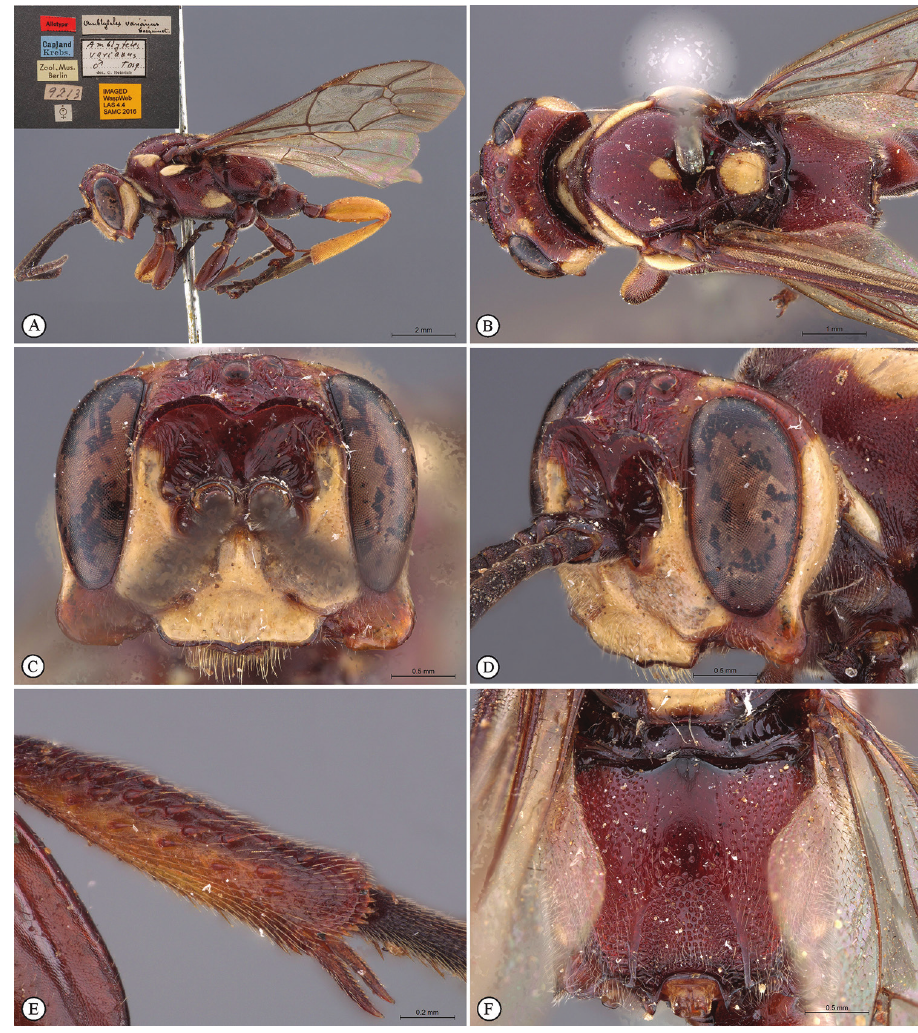
Figure 8. Genaemirum varianum (Tosquinet). Paratype female. A habitus lateral view (inset: data labels) B head, mesosoma, dorsal view C head anterior view D head, pronotum anterior-lateral view E fore-tibial armature F propodeum, dorsal